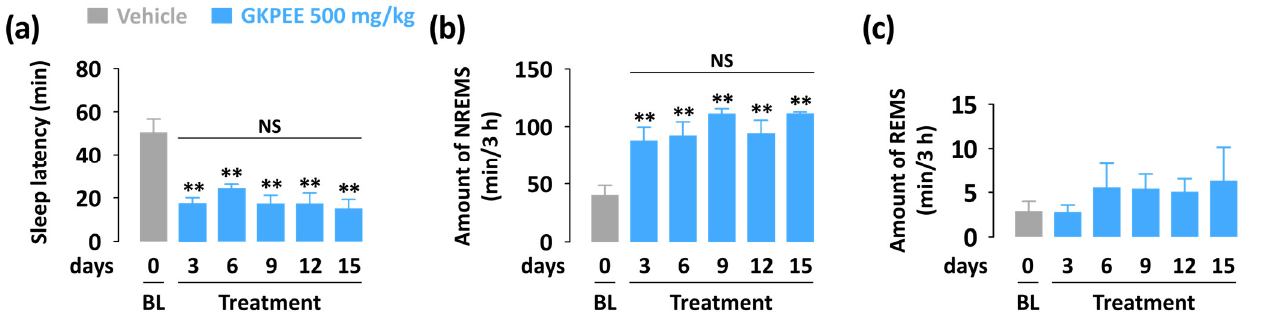
Figure 5. Effect of sub-chronic (15 days) administration of GKPEE on sleep latency ( a ). Amounts of NREMS ( b ) and REMS (C) during the 3 h after administration. ( c ) REMS amount. Columns represent the mean ± SEM of 7–8 mice. ** p < 0.01, significant as compared to the vehicle (Dunnett’s test). BL, baseline; GKPEE, green kiwifruit peel ethanol extract; NS, no significance; REMS, rapid eye movement sleep; NREMS, non-REMS; SEM, standard error of mean. To identify whether the sleep-promoting effects of GKPEE persist throughout the sub- chronic (15-day) treatment period, the delta activity of GKPEE was measured (Figure 6). The delta activity of GKPEE did not change throughout the administration period.